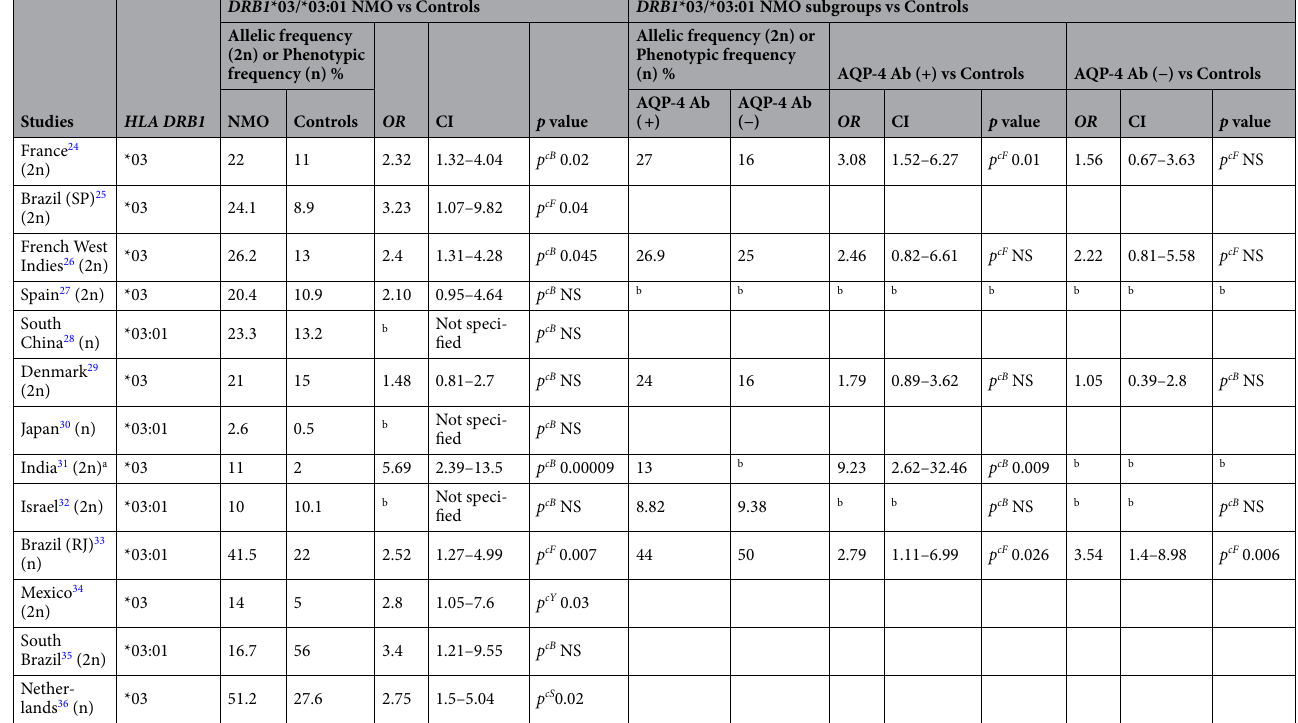
Table 3. Case controls studies that investigated the association of HLA DRB1 *03 allelic group and DRB1 *03:01 allele in NMO groups. NMO, Neuromyelitis Optica; IgG, Immunoglobulin G; AQP-4, Aquaporin-4; OR , Odds Ratio ; CI, Confidence Interval; p cF , p corrected by Fisher’s exact test; p cB , p corrected by Bonferroni method; p cY , p corrected by Yates method; p cS corrected by Sidak method; SP, São Paulo; RJ, Rio de Janeiro. a After stratification for AQP4 positivity no significant differences were observed between NMO subgroups and controls. b Data not